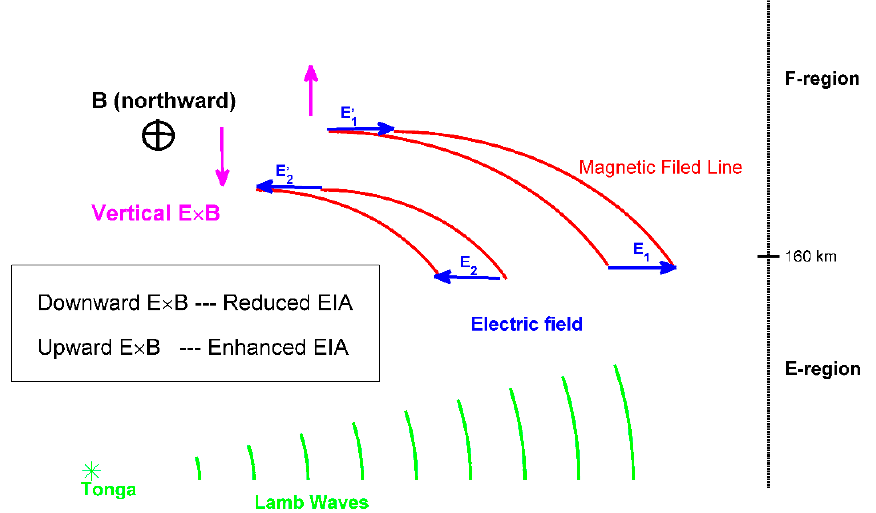
Figure 4. Schematic illustration of E- and F-region coupling during the Tonga eruption period. The green and red curves are Lamb waves and magnetic field lines, respectively. The blue and magenta arrows are electric fields and vertical E × B drifts, respectively. B is the magnetic field. E 1 and E 2 are electric fields.